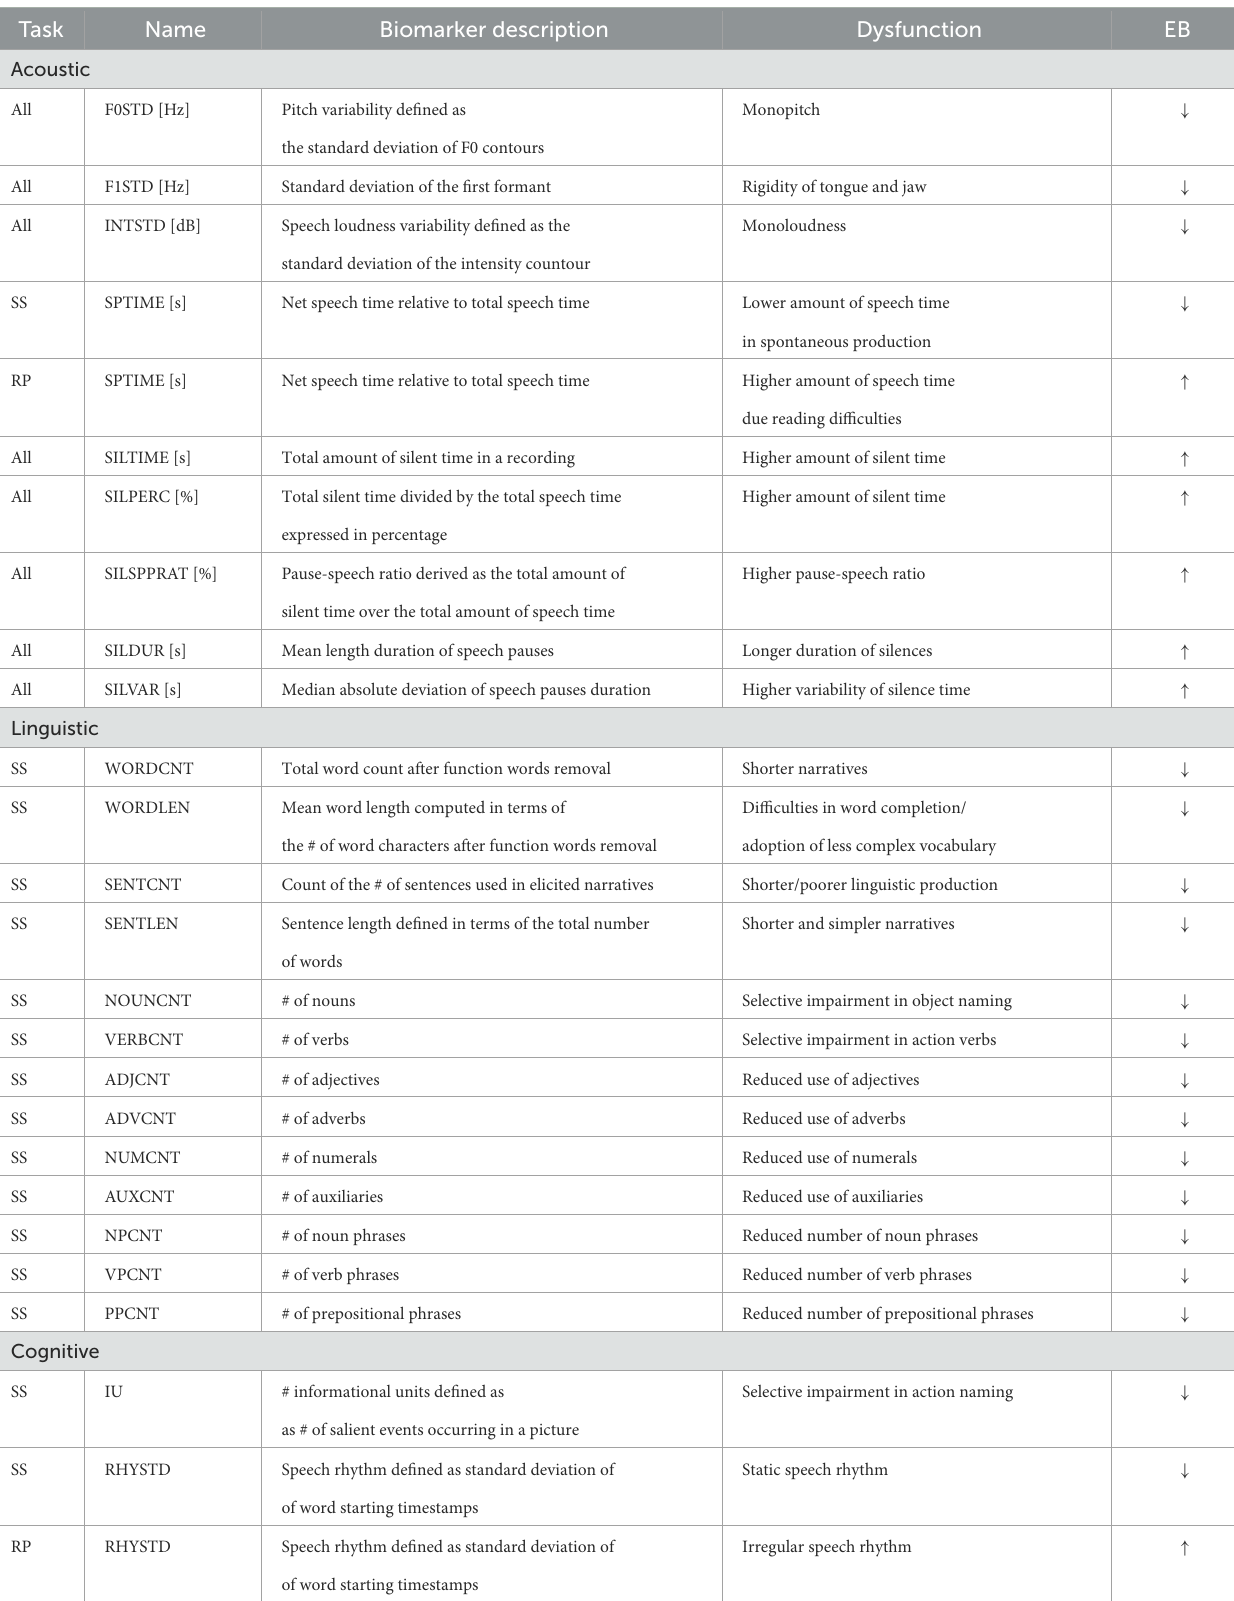
TABLE 4 Extracted acoustic, linguistic, and cognitive biomarkers.